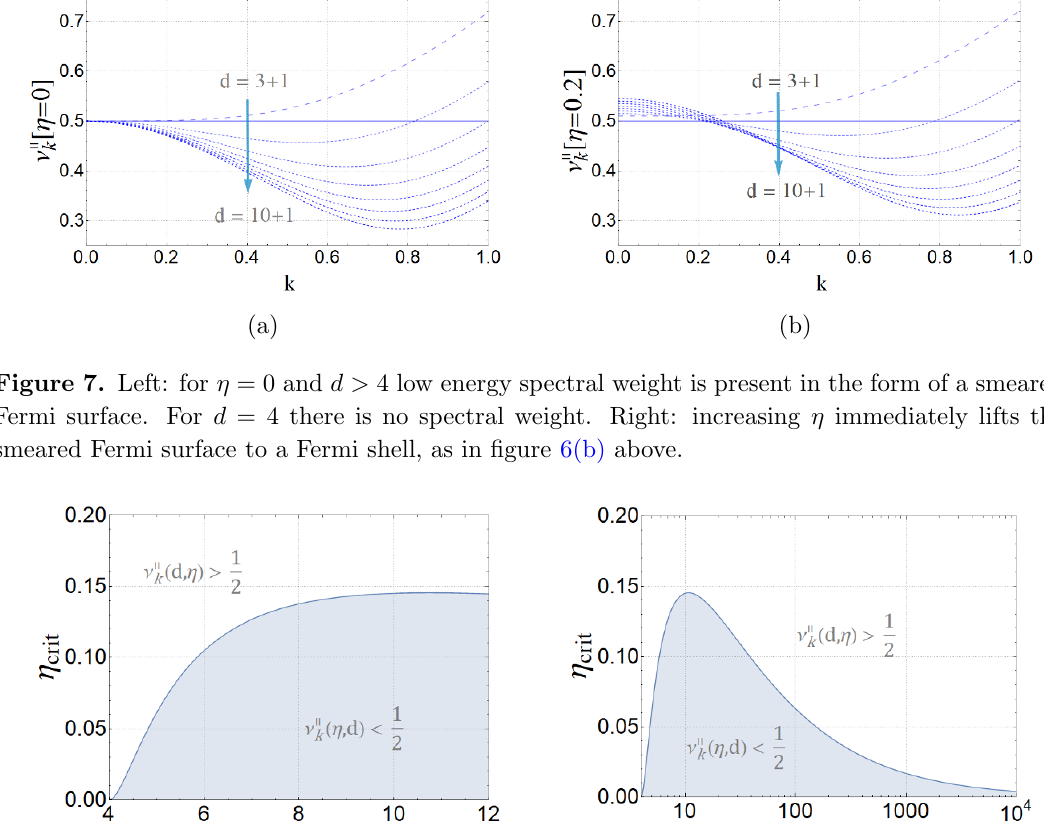
Figure 6. Left: for 3+1 bulk dimensions, the longitudinal channel exponent (cid:23) k the background metric parameter (cid:17) and momentum k. Right: for 4+1 bulk dimensions the longi- tudinal channel exponent is shown. Note that the 3+1 dimensional case is the critical case where no spectral weight is observed, whereas in 4+1 dimensions (and higher) spectral weight exists.